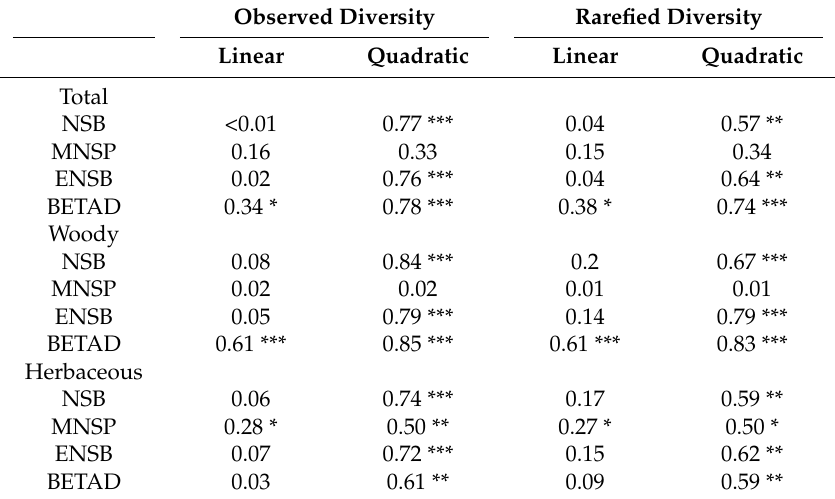
Table 2. Relationship between elevation and plant diversity with linear and quadratic models along the ridge of the Baekdudaegan Mountains, South Korea. Rarefied diversity was calculated with the same sample size ( n = 26) in each elevational